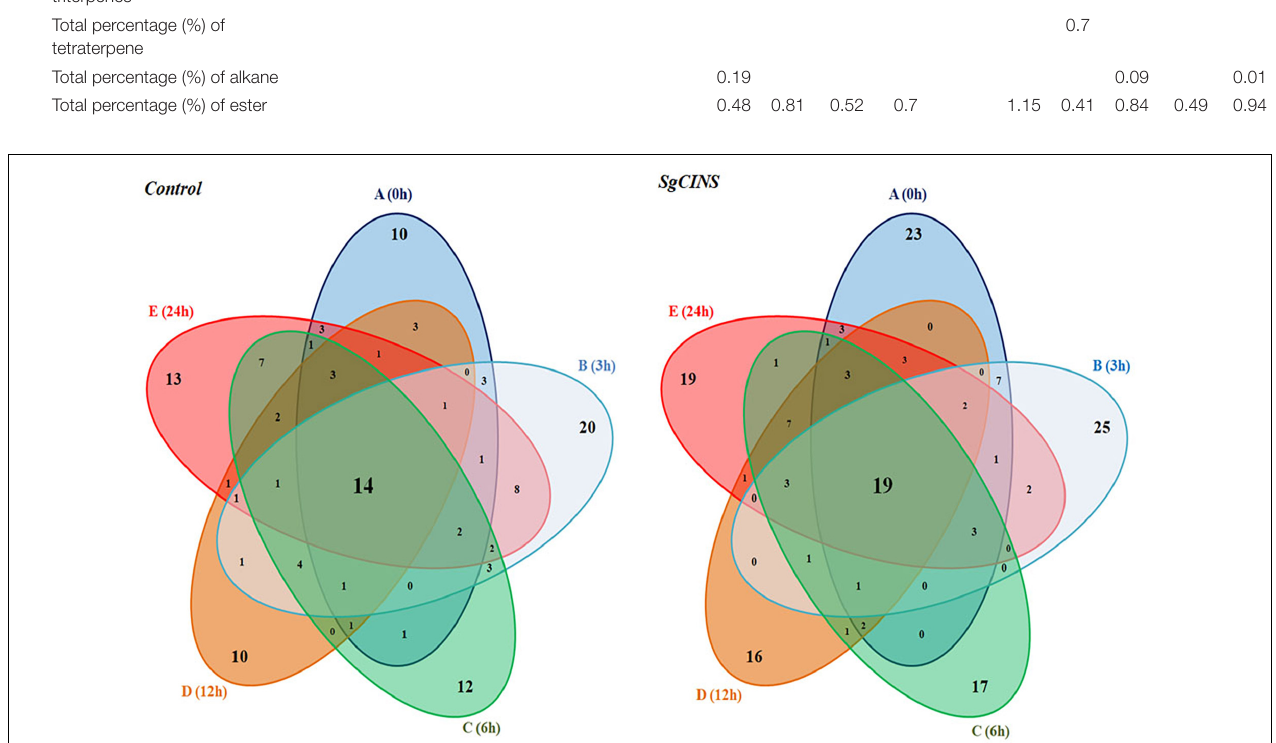
Frontiers in Plant Science |